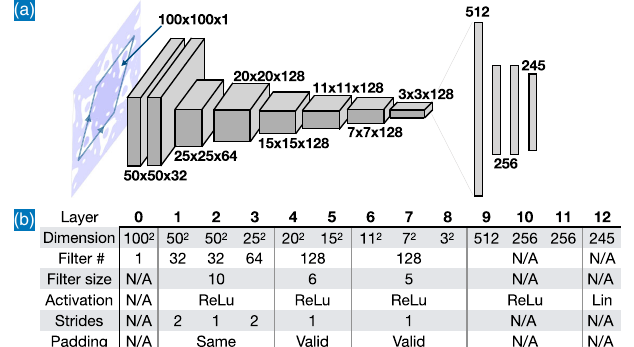
FIG. 7. Details of the NN layout. (a) Sketch of the layout of the neural network. The input image is the unit cell of the potential (the region within the blue contour). The numbers indicate the dimensions of the layers, where for the convolutional the last value is the number of filters. The image is flattened before it is processed by the dense layers. The final dense layer has 245 output neurons encoding the independent coefficients of the TB model. (b) Detailed list of the parameters for the network. “ Layer 0 ” labels the input